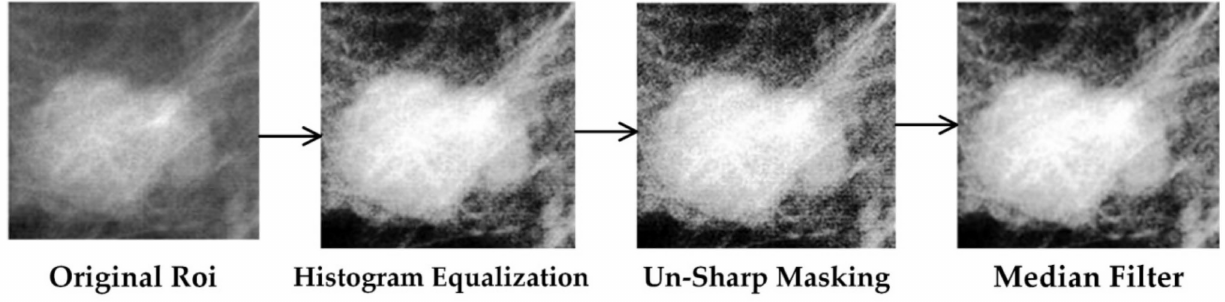
Figure 4. Sample of preprocessed mammogram